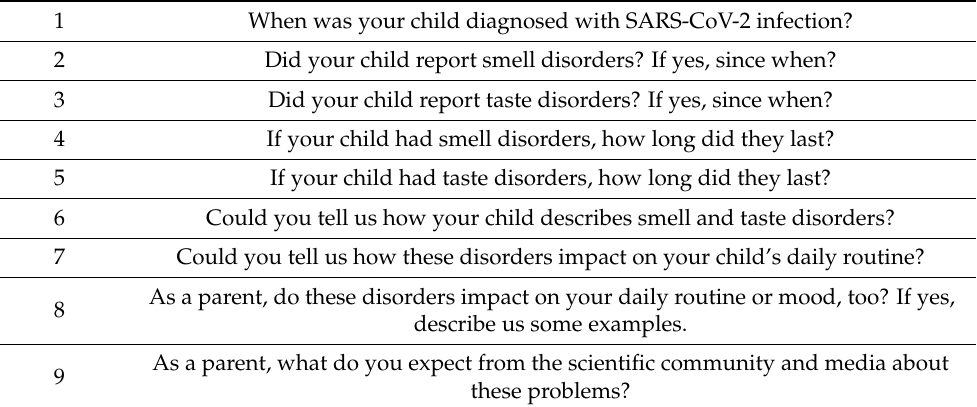
Table 2. Questions asked to children’s